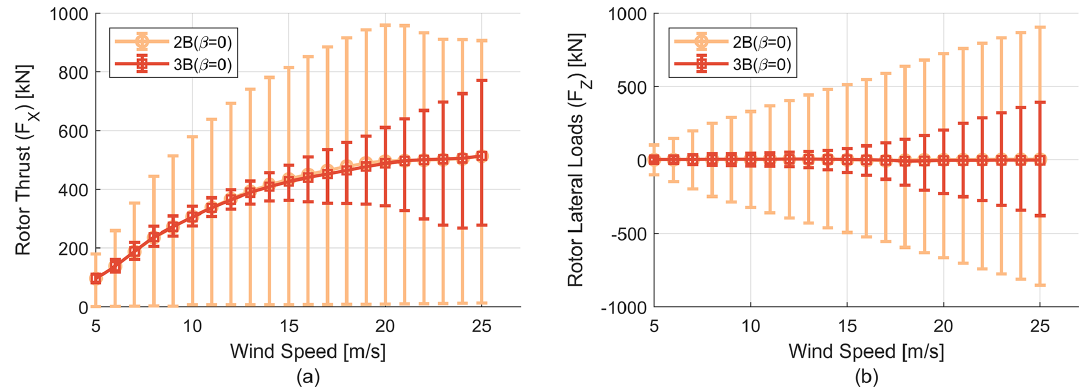
Figure 17. Thrust load ( F X ) and lateral load ( F Z ) during operating conditions. (a) Thrust load ( F X ) vs. wind speed. (b) Lateral load ( F Z ) vs. wind